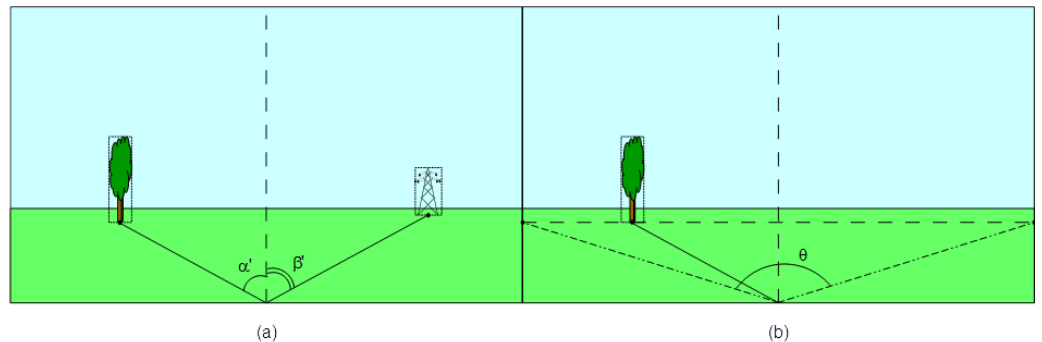
Figure 5. Computation of reference points